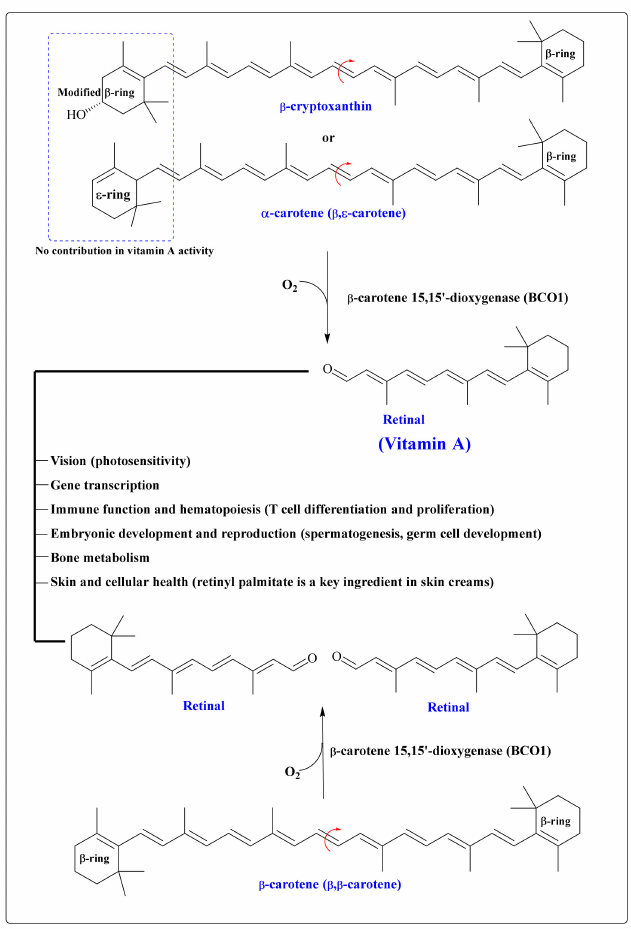
Figure 5. The presence of two unmodified β -ionone rings in one molecule of β -carotene can pro- vide two molecules of retinol (vitamin A; 100% provitamin A activity), while α -carotene and β - cryptoxanthin contain only one β -ionone ring structure (50% provitamin A activity). Beyond the rare exceptions, normal intake of CARs is considered safe [129]. The acceptable daily intakes (ADIs) of natural CARs and apo CARs, which are in the range of